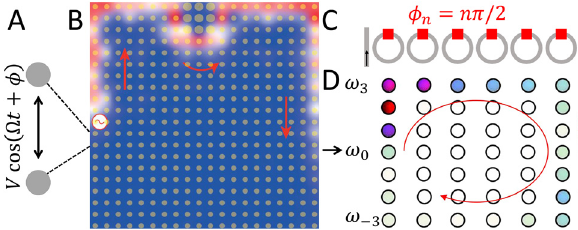
Figure 5: Dynamically modulated resonators generating effective magnetic fluxes. (A) Two resonators are connected through the dynamic modulation. (B) Topologically protected one-way edge mode propagates around the defect in a two-dimensional resonator lattice,wherethespatialdistributionof modulationphasesgivesan effective magnetic field. (C) An array of rings undergoing dynamical modulation, whichcreatesa syntheticspace(D)withone dimension being the frequency dimension, where a topological one-way edge mode can be excited. (A) and (B) are adapted from the study by Fang et al. [28]. (C) and (D) are adapted from the study by Yuan et al.